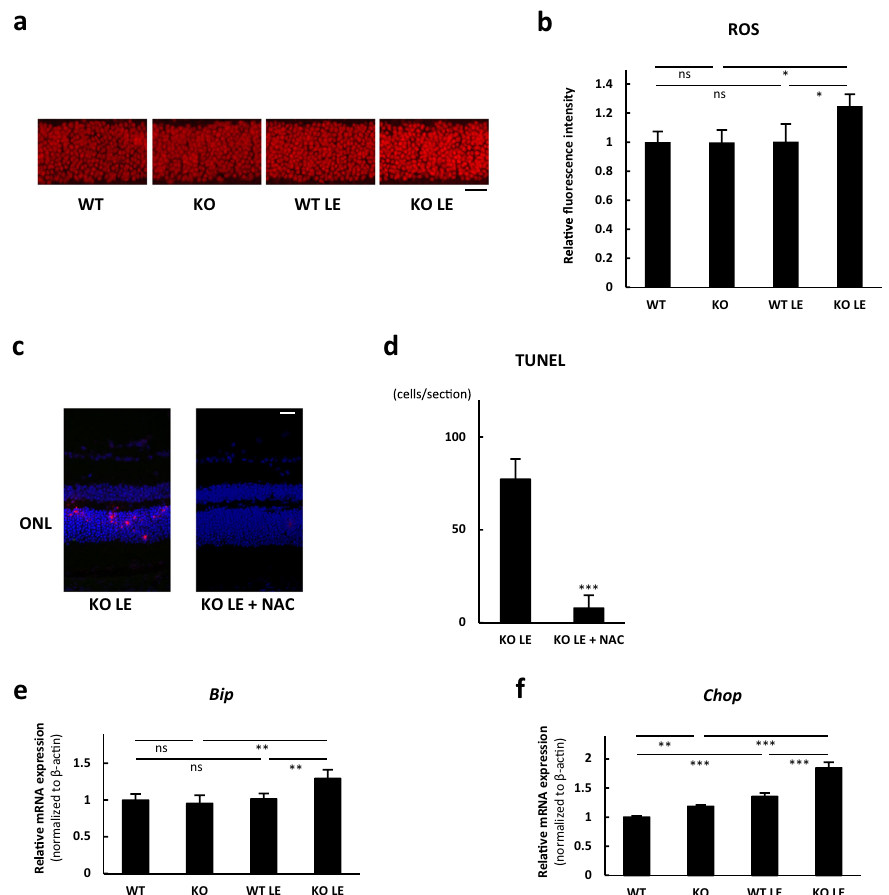
Fig. 5 SIRT3 KO retinas showed increased reactive oxygen species (ROS) and endoplasmic reticulum (ER) stress after the light exposure (LE). a , b Comparison of in vivo DHE staining for WT and SIRT3 KO outer nuclear layers (ONL) without and with LE (1 h after LE; WT n = 4, KO n = 4, WT LE n = 4, KO LE n = 5). Scale bars: 20 μ m. * p < 0.05, by one-way ANOVA with post hoc Tukey ’ s HSD test. c Representative images of terminal deoxynucleotidyl transferase dUTP nick end labeling (TUNEL) stain for SIRT3 KO retinas 36 h after the light exposure with control vehicle or N- Acetyl- L -cysteine (NAC) treatment. Blue: DAPI, Red: TUNEL. Scale bars: 20 μ m. ONL outer nuclear layer. d Comparison of TUNEL-positive cell counts per section ( n = 4 for control group and n = 6 for NAC treatment group). *** p < 0.001 by two-tailed unpaired t -test. e , f Expression of ER stress markers in WT and SIRT3 KO retinas without and with LE. Relative mRNA expression of e Bip and f Chop in the retina (1 h after LE; WT: n = 4, KO: n = 4, WT LE: n = 4, KO LE: n = 5). ** p < 0.01 and *** p < 0.001 by one-way ANOVA with post hoc Tukey ’ s HSD test. Values are mean ±